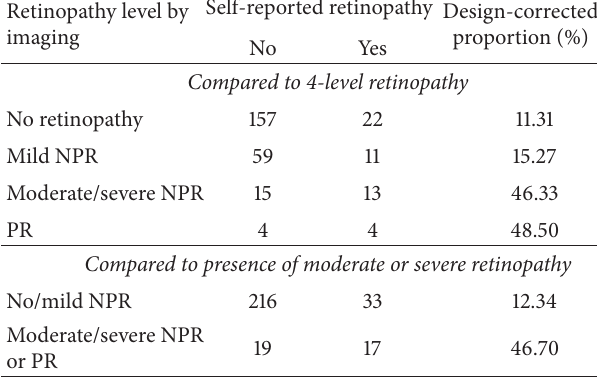
Figure 2: Monte Carlo simulations of the association of MOP with diabetic retinopathy after applying the misclassification rates observed in the validation sample. This plot shows the histogram of 5,000 logistic regression coefficients with an overlaid normal curve. All models use inverse-normalized concentrations of phthalate metabolites. OR, odds ratio; CI, confidence interval; 𝑃 , significance value.